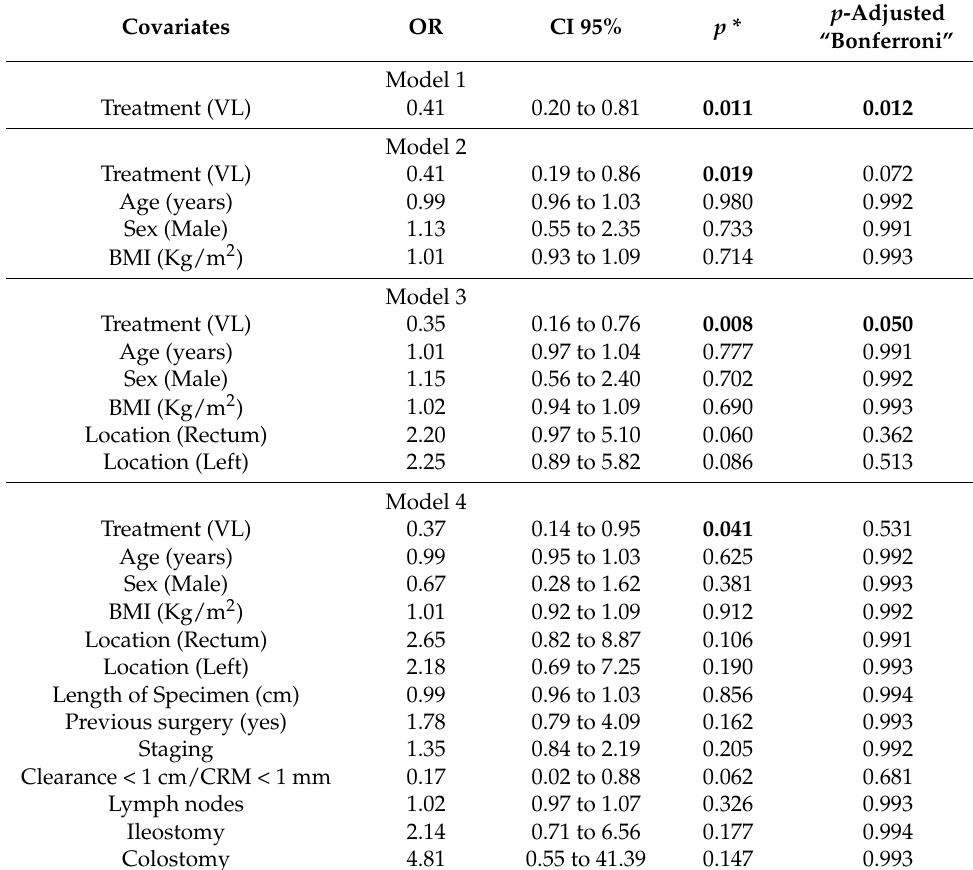
Table 4. Ordinal logistic regression model based on Clavien–Dindo classification.